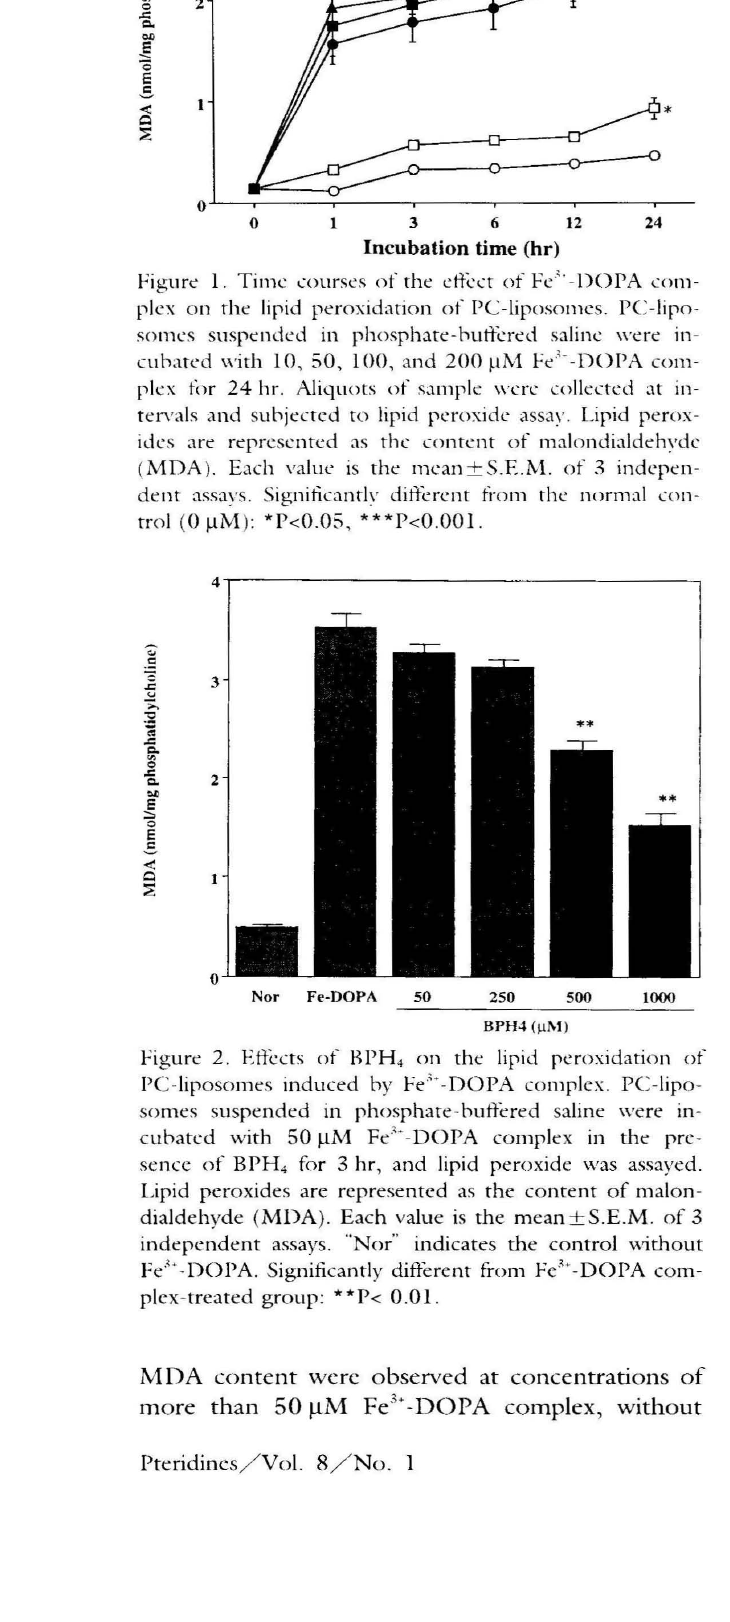
Table I . Inhihirnrl' potency of BPH ers against lipid peroxidation of PC-liposomes induced bl' h:" -1)OPA